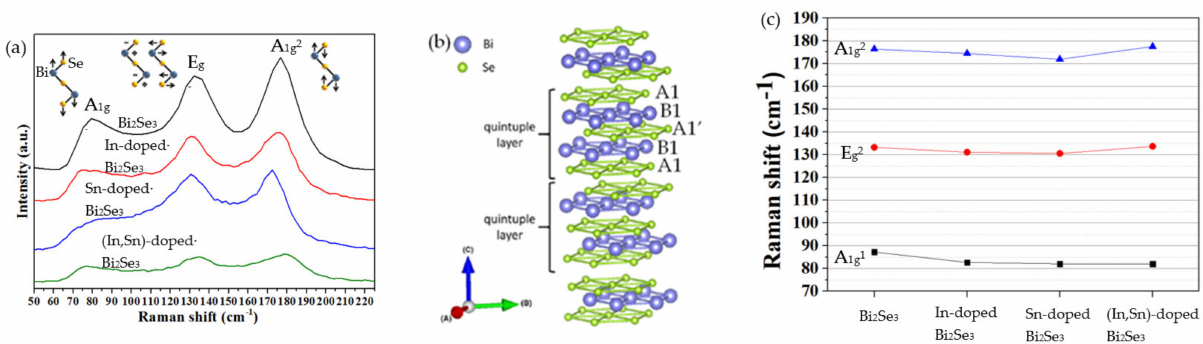
Figure 5. ( a ) Raman spectra of pristine, and In-, Sn-, and (In, Sn)-doped Bi 2 Se 3 nanoplatelets; the inset is the schematic vibration modes of A 1g1 , E g2 , and A 1g2 [56,58]. ( b ) Schematic layered structure of Bi 2 Se 3 [55]. ( c ) Variations of Raman shift at A 1g1 , E g2 , and A 1g2 with different dopants. Table 4. Characteristic Raman peaks of the pristine, and In-, Sn-, and (In, Sn)-doped Bi 2 Se 3 nanoplatelets.